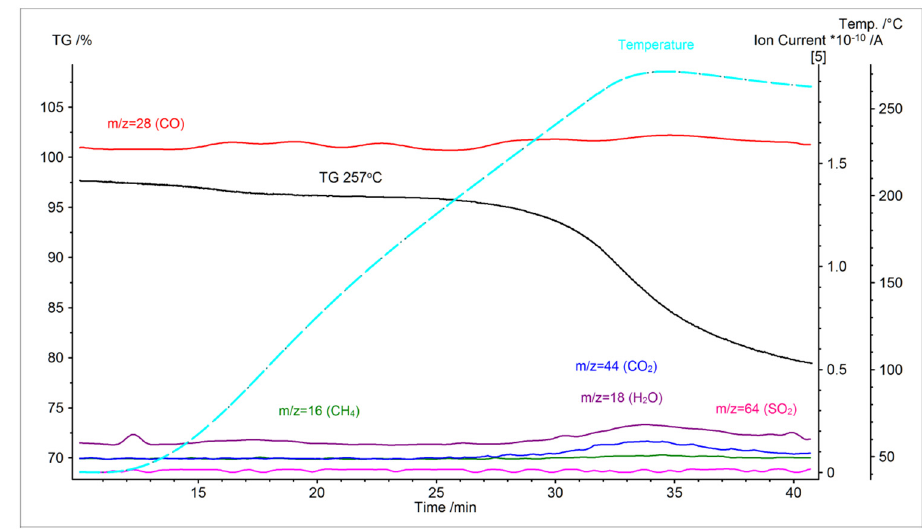
Figure A3. Thermogravimetric and ion current curves for the Miscanthus torrefaction process up to 257.5 °C.